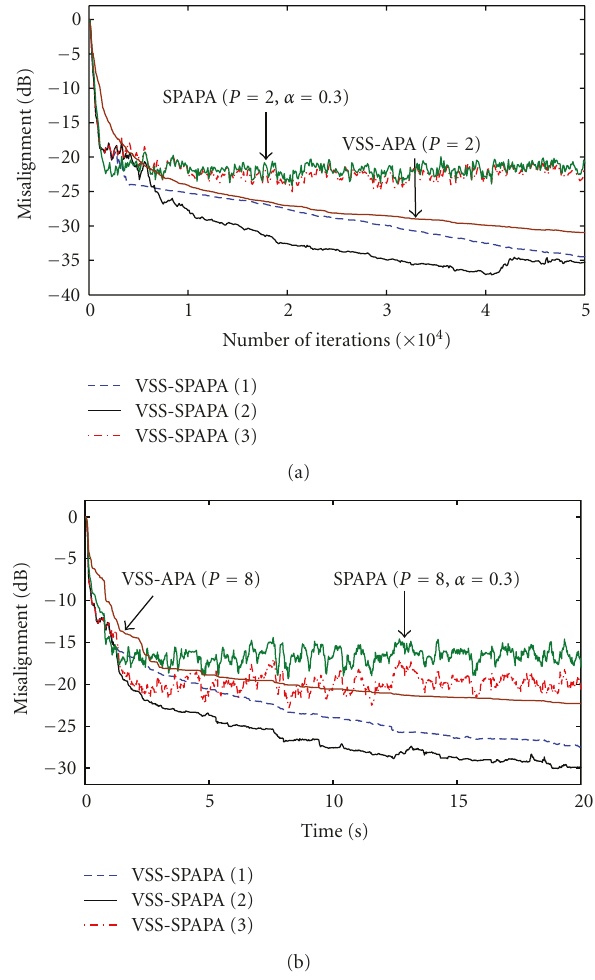
Figure 6: Misalignment of the relevant algorithms with inaccurate ( t ). (a) With highly colored input signals generated estimate of (cid:18) σ 2 v by G ( z ). P = 2. (b) With speech input signals, P = 8. (1) (cid:18) σ 2